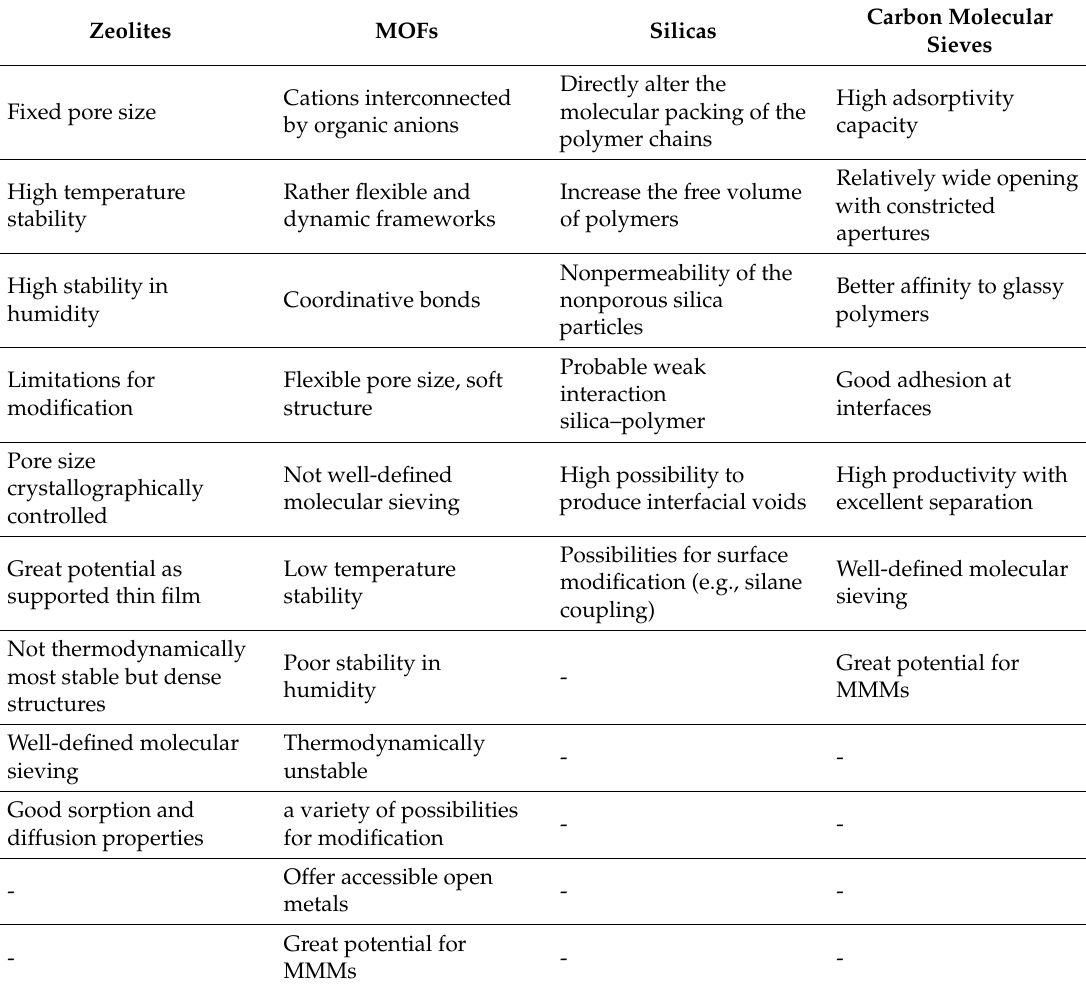
Table 1. Features of some filler materials used for MMM preparation